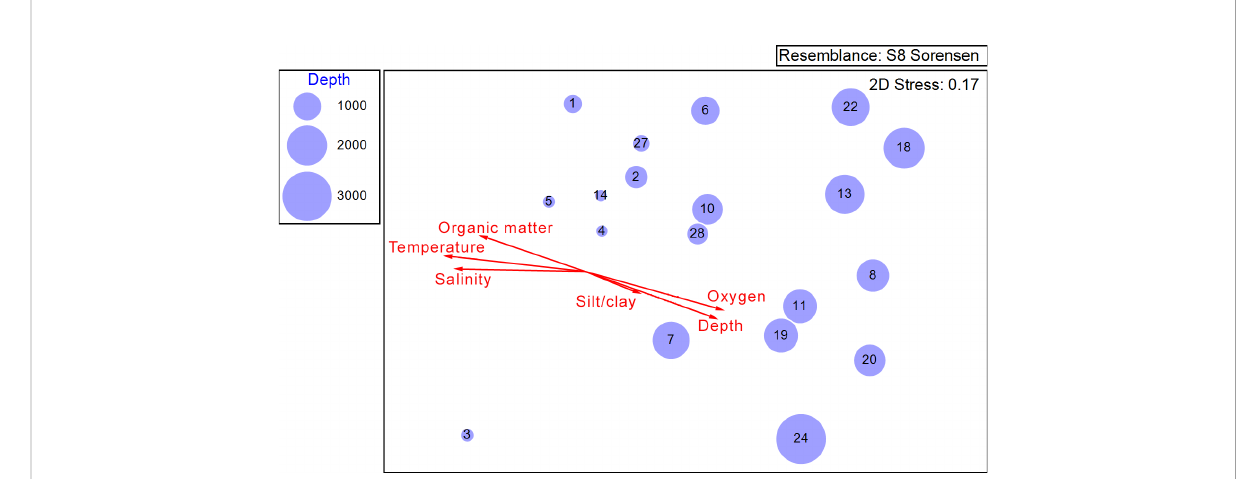
FIGURE 4 Nematode assemblage structure represented by a NMDS numerical ordination of 19 sites in the Southwestern Gulf of Mexico based on the presence/absence of species. Bubble size is proportional to the water depth at each site. Vectors represent the Pearson correlation between abiotic variables and the ordination